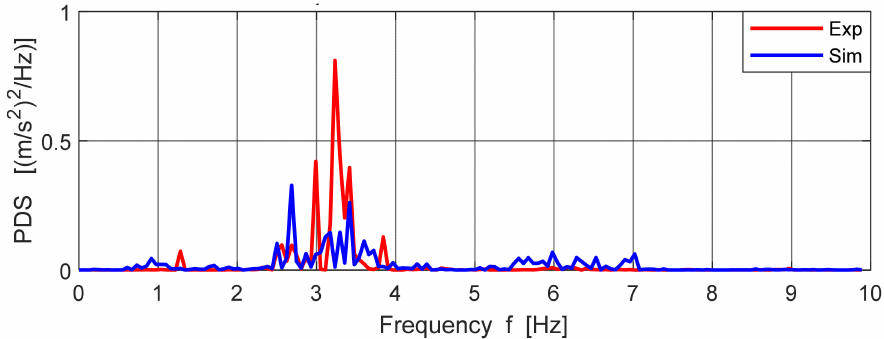
Figure 19. PSD of vertical accelerations in vehicle CG, 0–10 Hz.